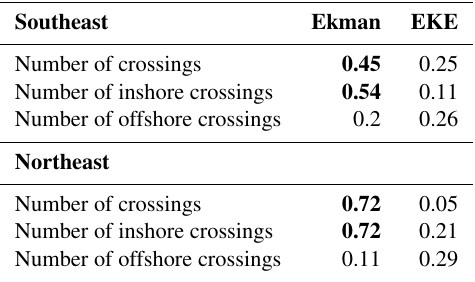
Table 2. Correlation of the number of crossings in the southeast– northeast and the EKE and Ekman transport in the same region. The table shows the r value of each correlation, printed in bold if the correlation is significant within 99% confident